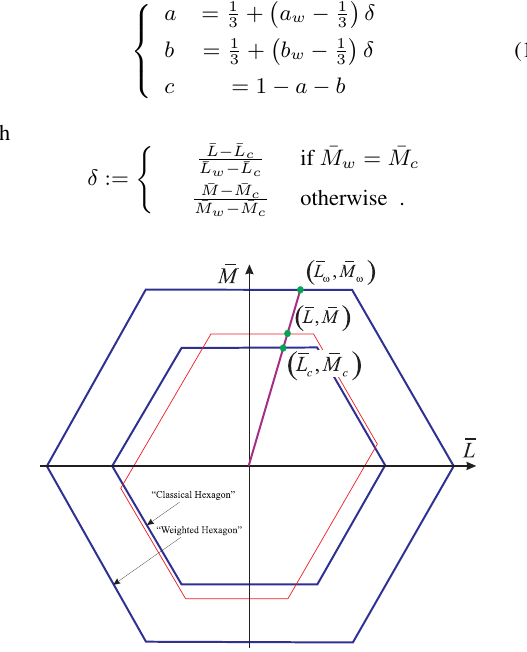
Figure 8: Interpolation method for the determination of a; b;